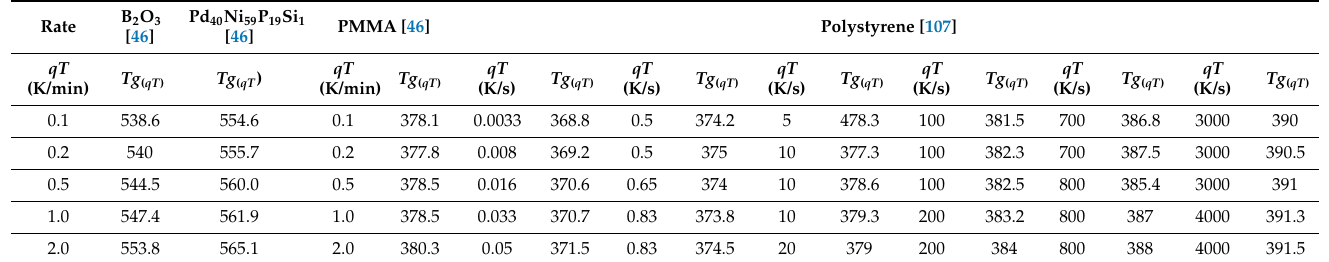
Table 3. Measured Tg ( qT )